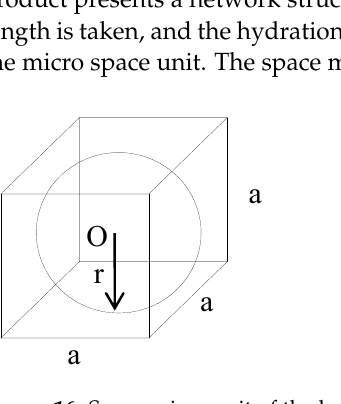
Figure 16. Space micro unit of the hydration product. O is the central point of the hydration product. r is the radius of the spherical hydration product. a is space micro unit length size.